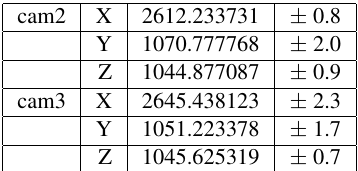
Table 9: Resulting coordinates of the projection centers of two cameras. From To